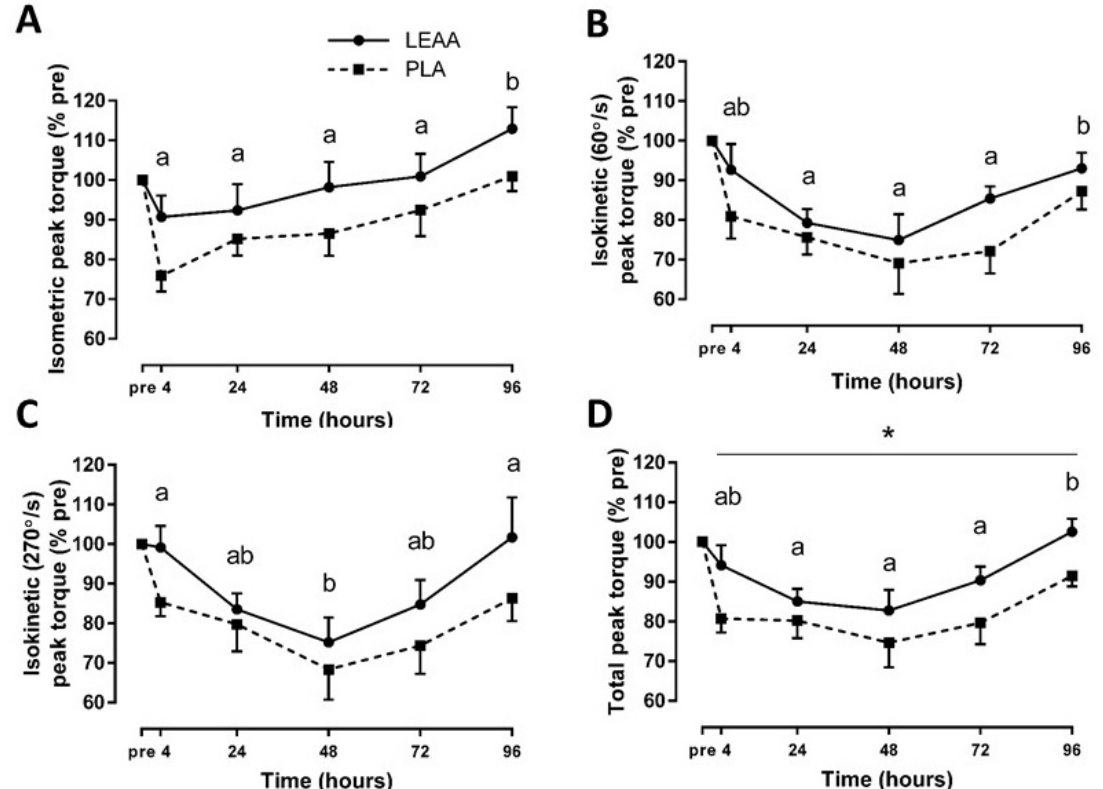
Figure 3. Mean (± SEM) isometric ( A ), isokinetic 60°/s ( B ), isokinetic 270°/s ( C ), and total ( D ) peak torque after resistance exercise in response to LEAA or placebo consumption. * Significant effect of group ( p < 0.05). Time points with different letters are significantly different from each other (main effect for time, p < 0.05). Pre, pre‐exercise; PLA, placebo. Table 2. Effect sizes and confidence intervals for isometric, slow isokinetic, fast isokinetic, and total peak torque after resistance exercise in response to LEAA versus placebo consumption. Thresholds for small, moderate, and large effect sizes are 0.2, 0.5, and 0.8, respectively.